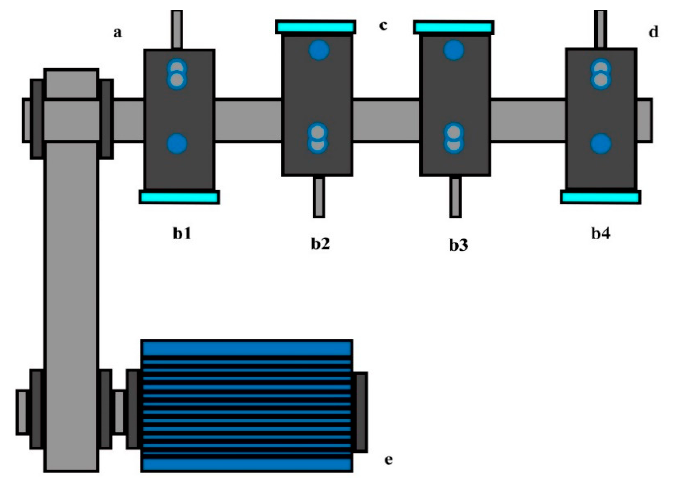
Figure 7. An illustration of the Intelligent Maintenance Systems (IMS) test rig for bearing run-to- failure dataset. In the figure, (a) two accelerometers, four bearings as b1, b2, b3 and b4, (c) a radial load, and (d) four thermocouples which are attached to the outer race of each bearing.